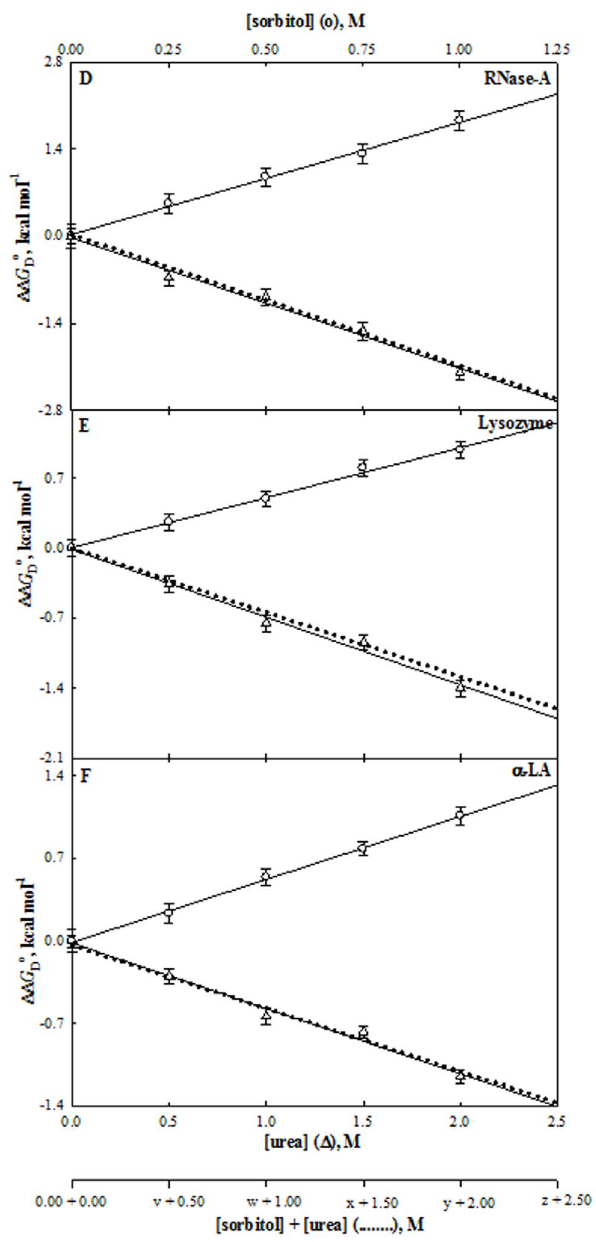
Figure 6. Effect of taurine, urea and their mixtures on stability of proteins at pH 7.0 and 25 6 C. Plots of DD G Do versus [taurine] ( # ) and [urea] ( D ). The dotted line represents the DD G Do values measured at the predicted ratios (see Table 2). The values of v, w, x, y and z of each protein are those predicted from results given in Table 2. For instance, values of y for taurine are 0.60, 0.48 and 0.40 M for RNase-A, lysozyme and a -LA, respectively.